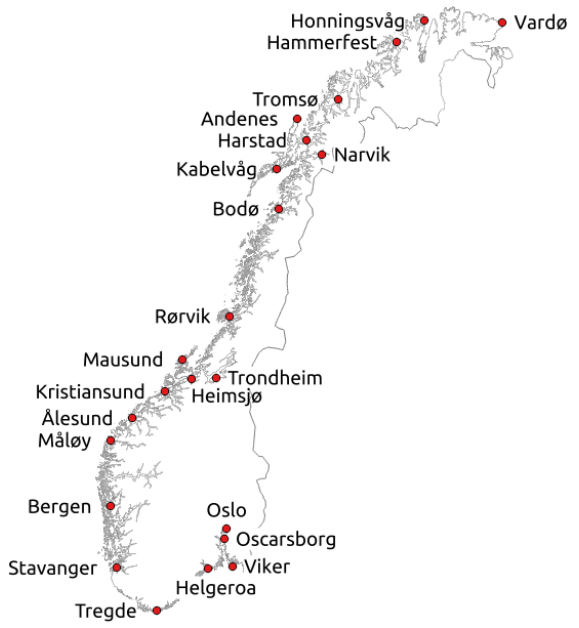
Figure 1. Locations of Norwegian tide